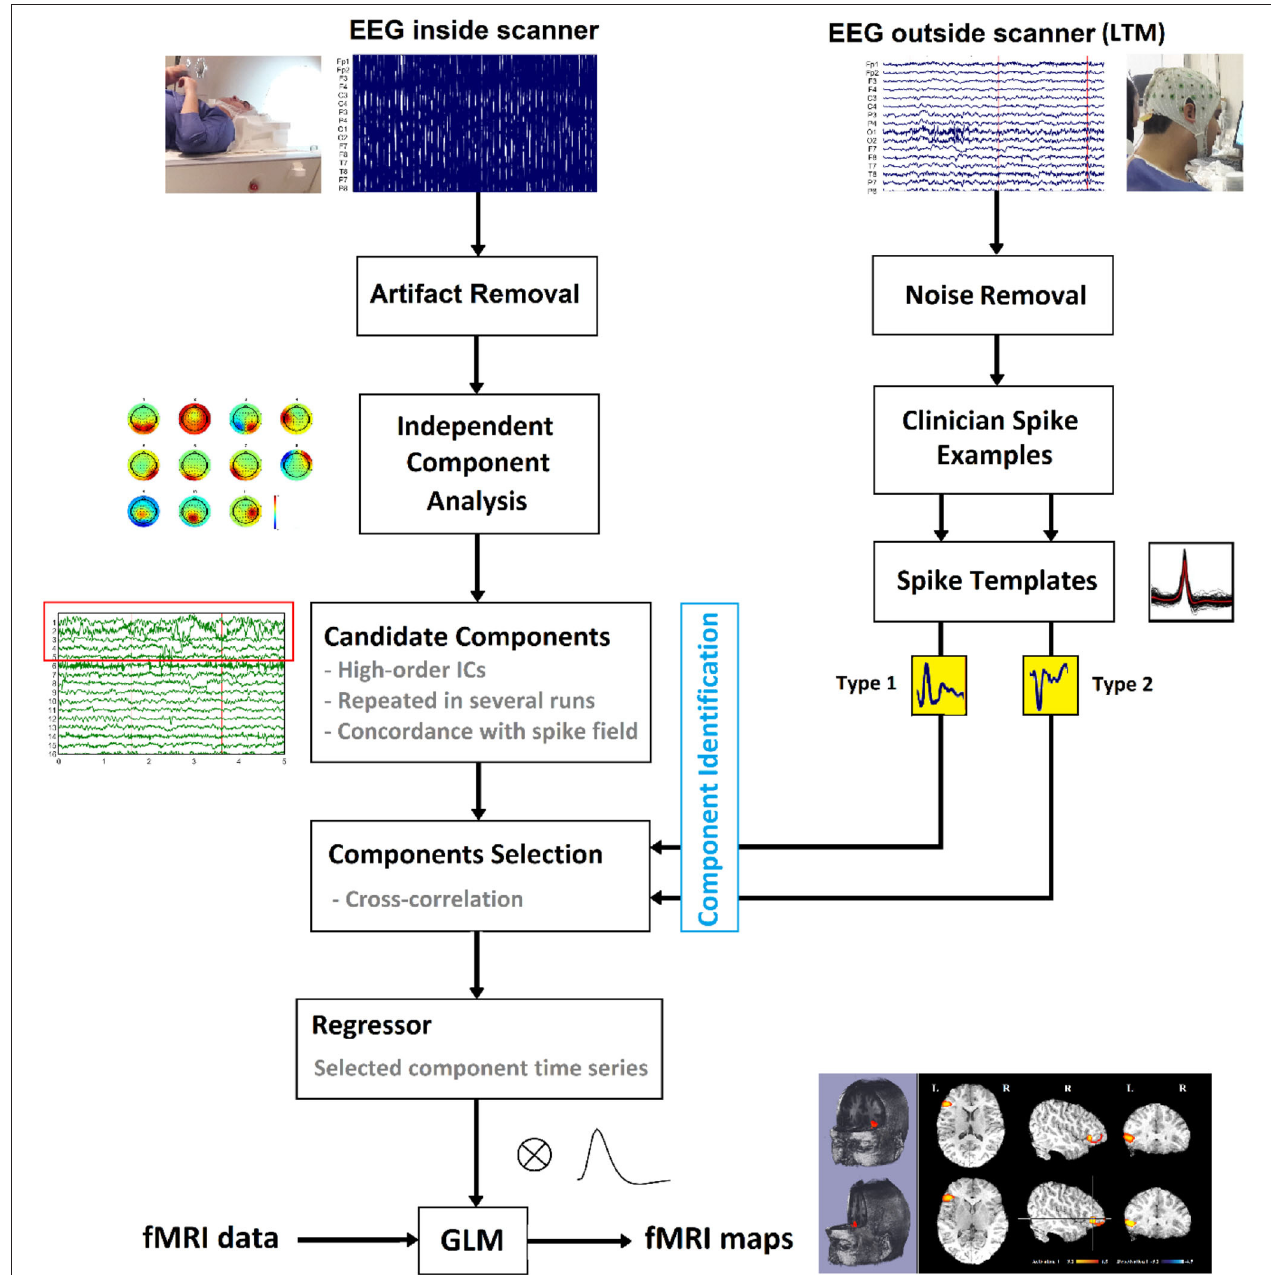
FIGURE 3 | Schematic of the suggested method to localize the epileptic foci using simultaneous